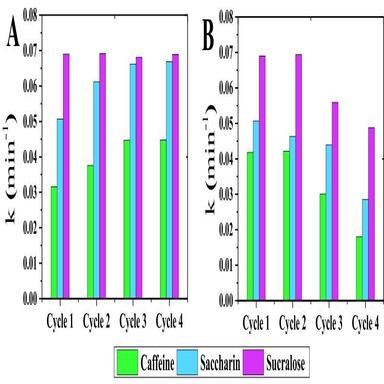
Removal rate of the contaminants after 4 cycles using (A) water and UV-C irradiation and (B) UV-C irradiation as regeneration procedures. Initial concentration of the contaminants = 2 mg L− 1 and SGIP = 25 mg L− 1 .